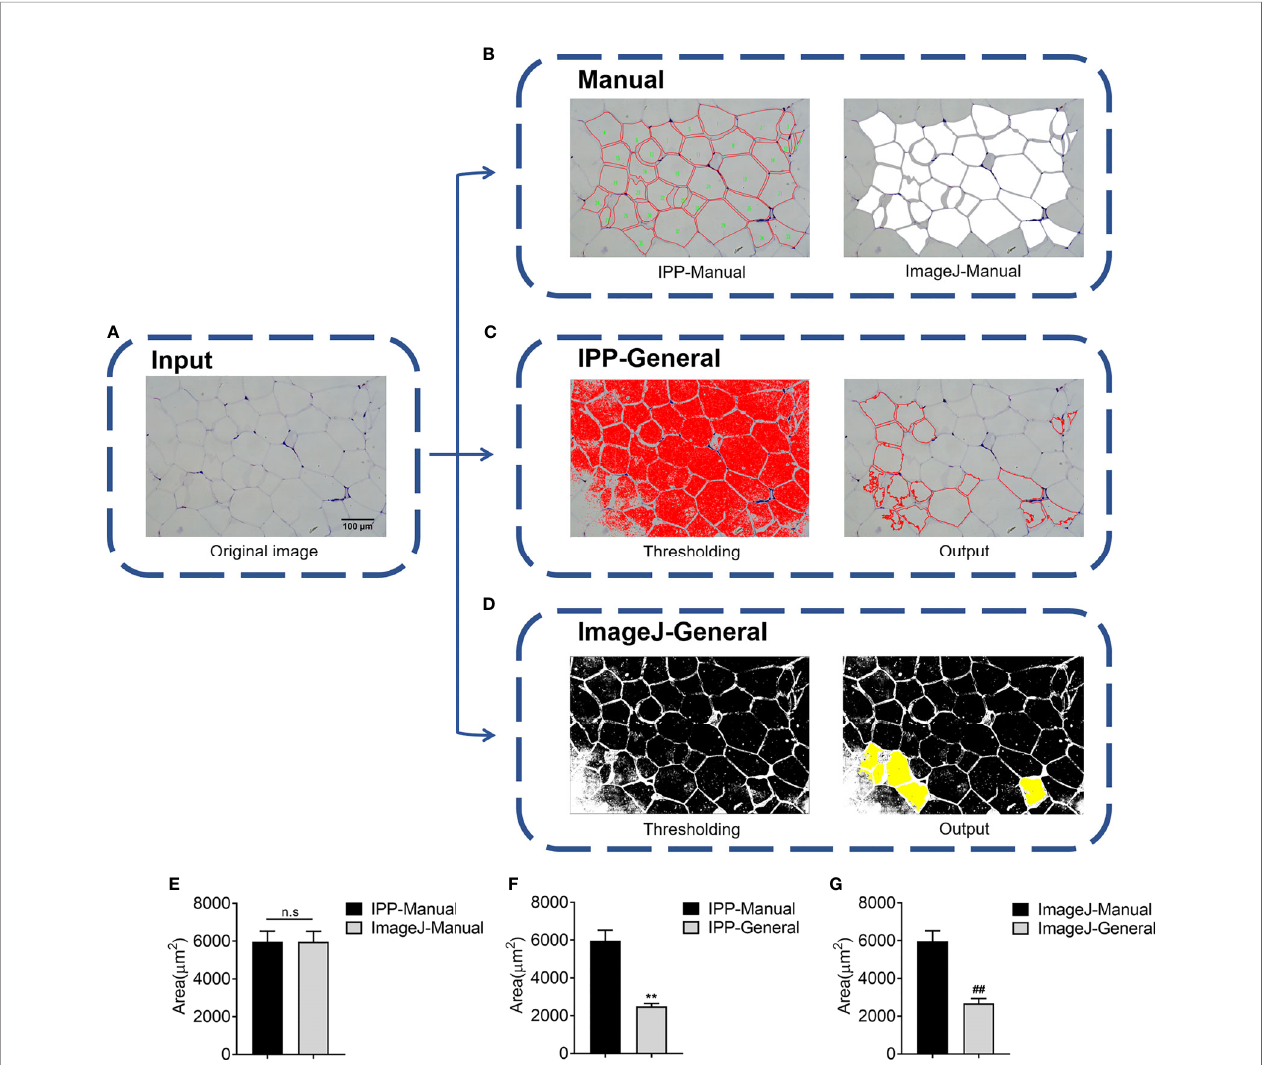
FIGURE 1 | Adipocyte sizes measured by manual and general methods respectively with IPP/ImageJ. (A) Original image of adipocytes. (B) Manual segmentation results of IPP (left) and ImageJ (right). (C) General segmentation results of IPP, the image after threshold adjustment (left), and the output image, where the red circles represented identi fi ed adipocytes (right). (D) General segmentation results of ImageJ, the image after threshold adjustment (left), and the output image, where the identi fi ed adipocytes were fi lled with yellow (right). (E) Adipocyte sizes measured by manual methods with IPP and ImageJ. (F) Adipocyte sizes measured by manual and general methods with IPP. (G) Adipocyte sizes measured by manual and general methods with ImageJ. Data are presented as mean ± SEM and **P < 0.01 compared to IPP manual measurement group. ## P < 0.01 compared to ImageJ manual measurement group. n.s., not signi fi cant; IPP, Image-Pro